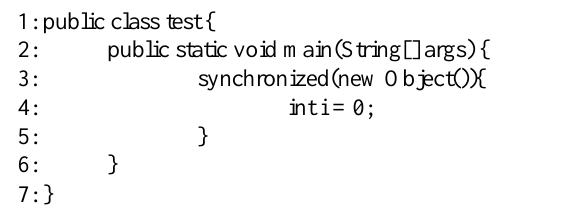
Figure 5. The sample code of synchronized objects